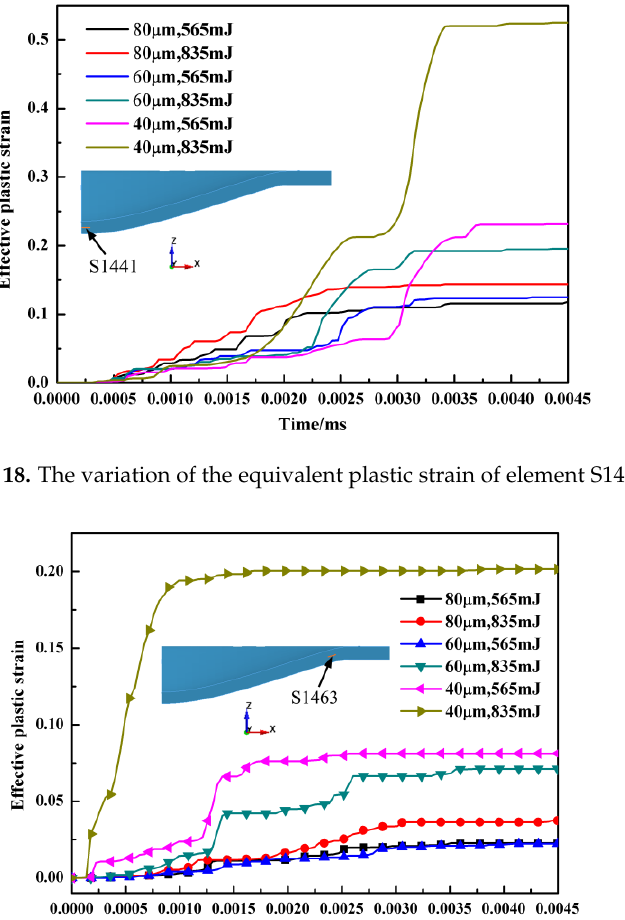
Figure 17. The equivalent plastic strain distribution of the micro bulging parts under different